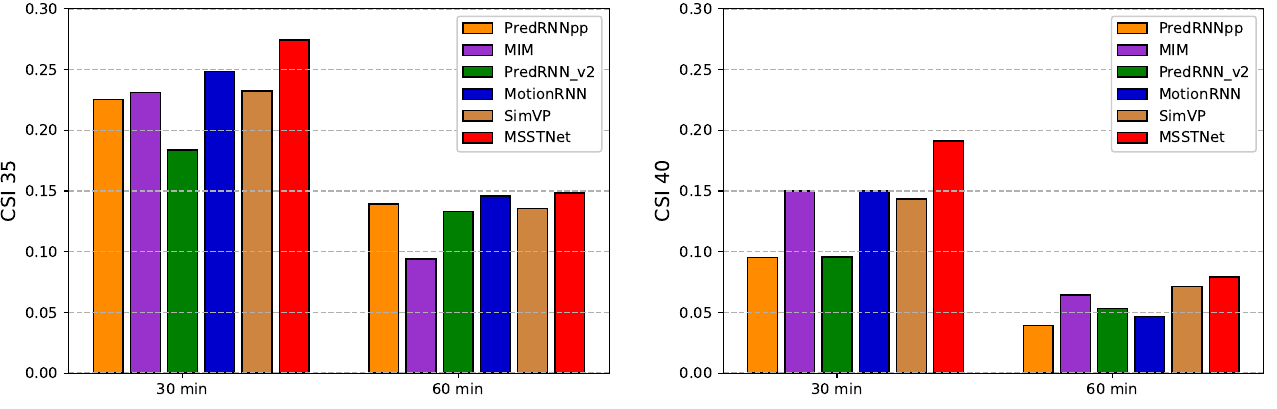
Figure 7. Quantitative comparison of multiple CSI